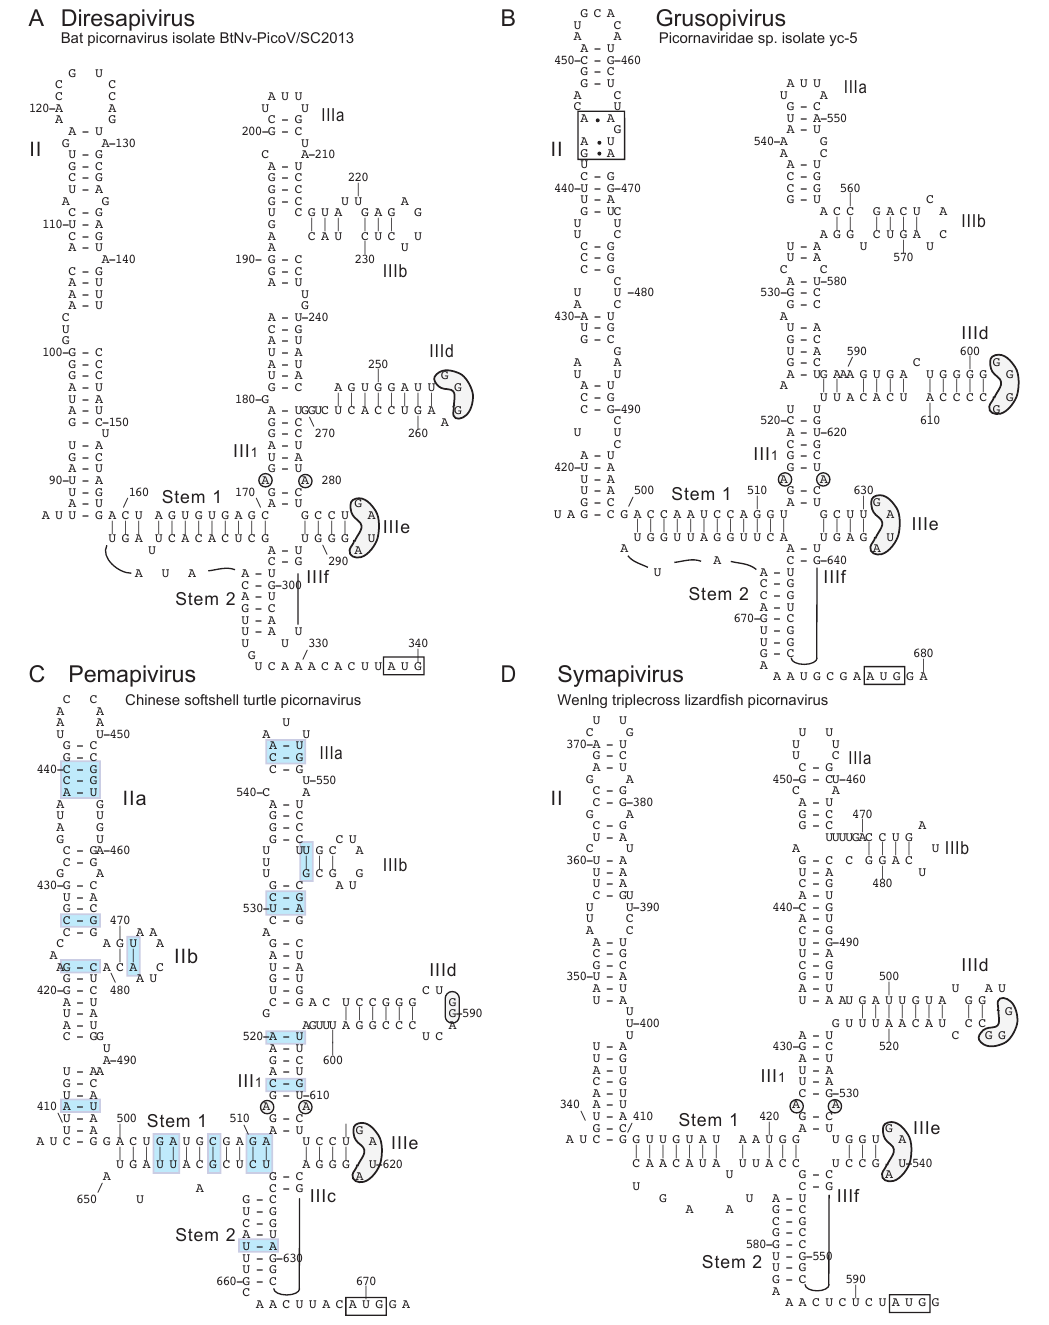
Figure5. TypeIVIRESsinmembersofthegenera Diresapivirus , Grusopivirus , Pemapivirus and Synapivirus . ( A ) Model of the structure of the diresapivirus B1 IRES (GenBank: KJ641697.1) (genus Diresapivirus ), ( B ) Model of the structure of the grusopivirus A1 IRES (crane picornavirus 5) (GenBank: KY312544.1) (genus Grusopivirus ), ( C ) Model of the structure of the pemapivirus A1 IRES (Chinese softshell turtle picornavirus) (GenBank: MG600106.1) (genus Pemapivirus ) and ( D ) Model of the structure of the symapivirus A1 (Wenling triplecross lizardfish picornavirus) (GenBank: MG600076.1)